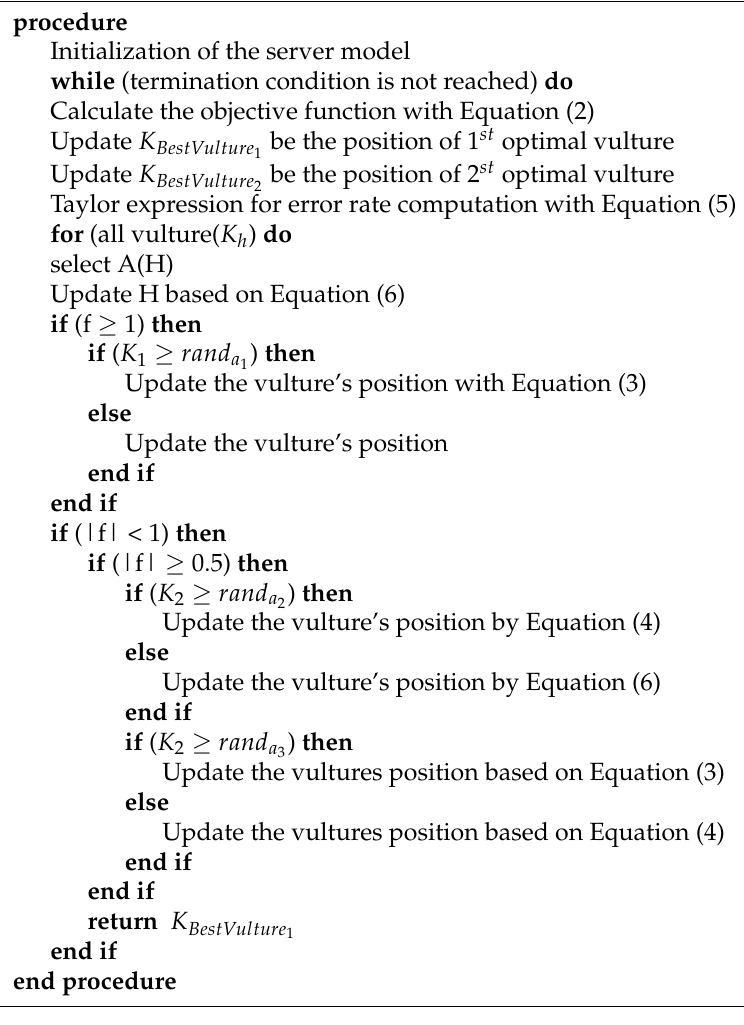
Algorithm 3 The pseudo-code for the Taylor African Vulture